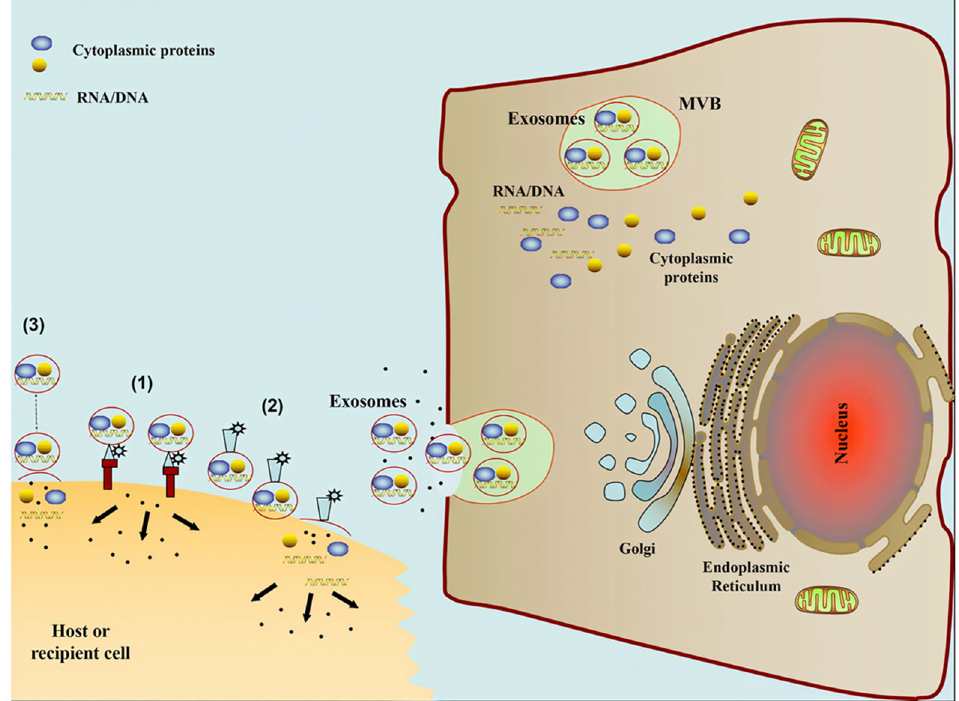
Figure 4. A schematic diagram of pathways involved in exosome-mediated cell-to-cell communi- cation. (1) Exosomes signal recipient cells via direct surface-bound ligands. (2) Exosomes transfer activated receptors to recipient cells. (3) Exosomes may epigenetically reprogram recipient cells via delivery of functional proteins, lipids, and RNAs [7]. Figure and caption reproduced with permission from Springer Nature.